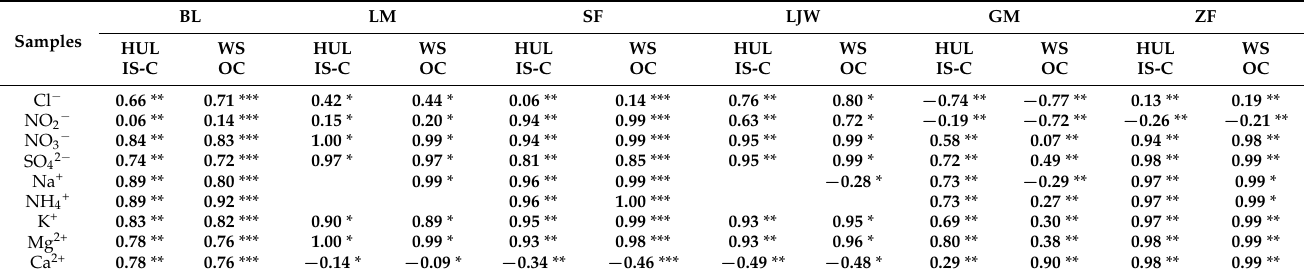
Table 7. The correlation between HULIS-C and WSOC and water-soluble ions in RCC particles.